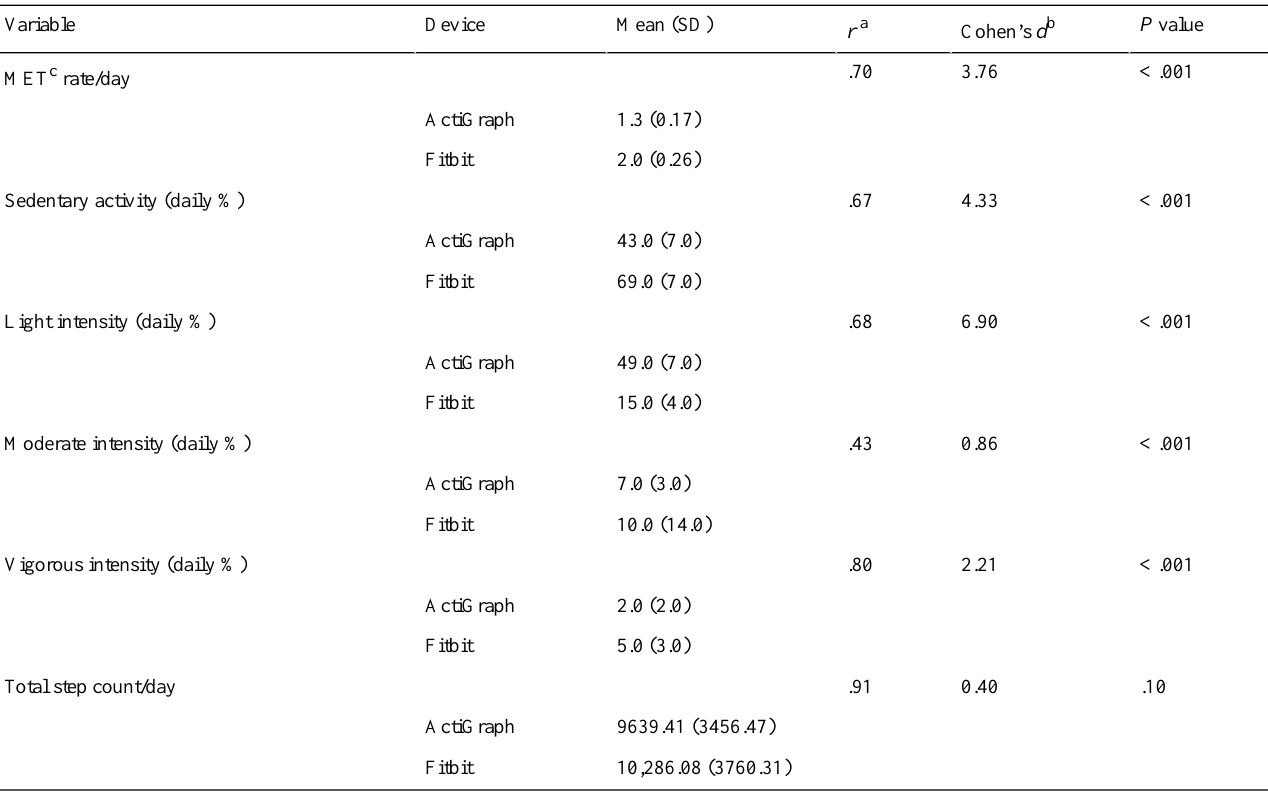
Table 2. Average day-level differences for activity variables between devices